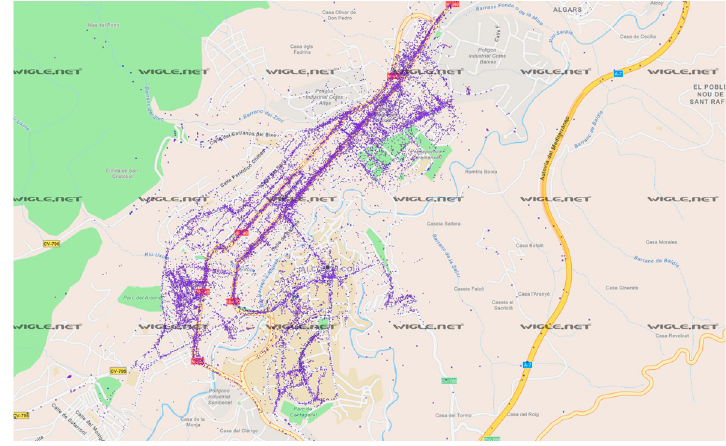
Figure 5. WiGLE map of SSIDs collected in the city of Alcoi.